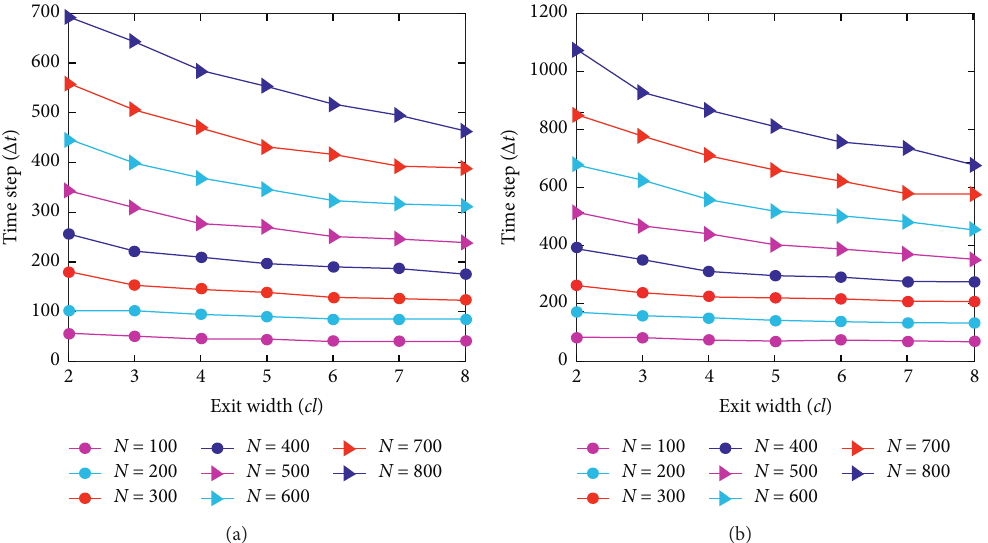
Figure 22: Total evacuation time steps of the improved model and CA model with different number of people. (a) Improved model. (b) CA